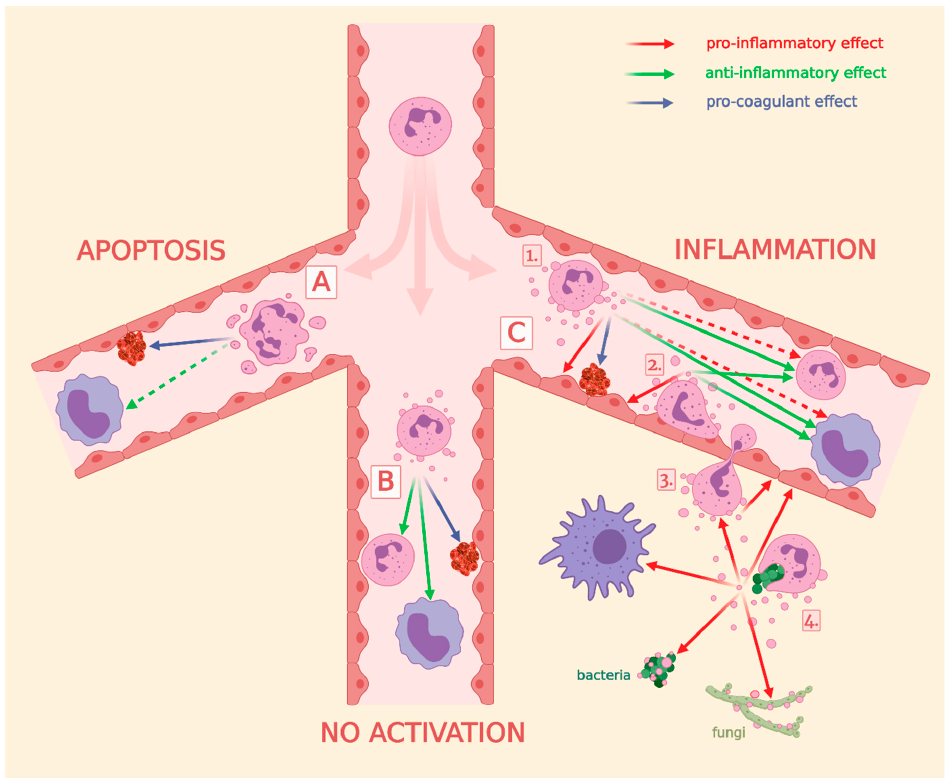
Figure 4. Overview of the role of PMN-EVs in intercellular communication, in coagulation and in pathogen elimination. Part ( A ) effects of apoEVs, ( B ) effects of spontaneous produced EVs, and ( C ) effects of EVs generated during inflammation. Numbers represent certain steps of PMN activation: ( 1 ) circulating PMNs, ( 2 ) endothelium-attached PMNs, ( 3 ) PMNs during extravasation, ( 4 ) PMNs after phagocytosing pathogens. Green arrows represent anti-inflammatory, red arrows represent pro-inflammatory, blue arrows represent pro-coagulant effects. Broken arrows represent non-consensual effects. References behind the arrows are listed in Table 2. Table 2. List of publications behind Figure 4 and impact of PMN-EVs on target cells. Group (Figure 4)